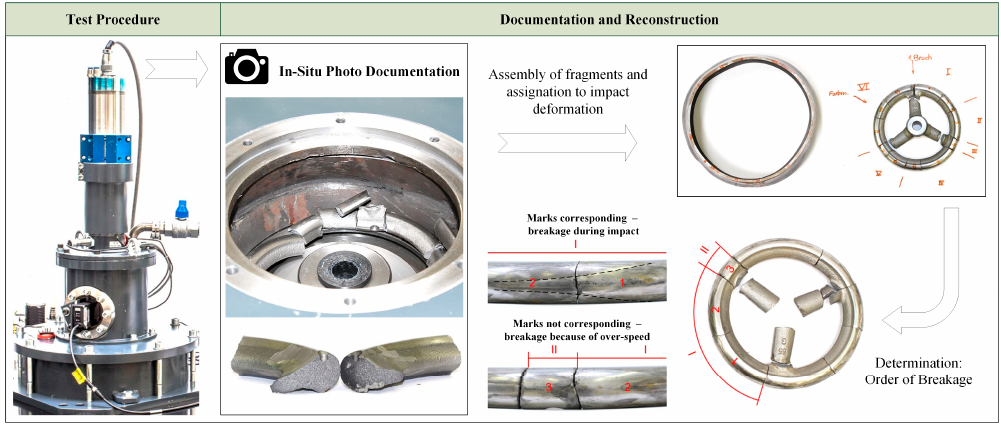
Figure 12. Step 1—Documentation and reconstruction.